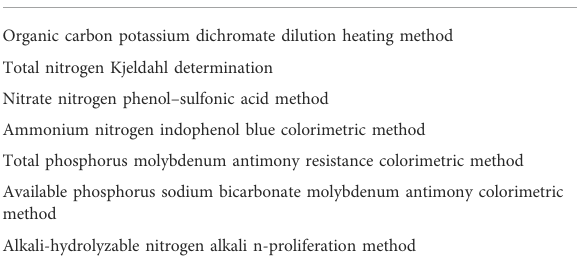
TABLE 1 Study outline of the experimental method.